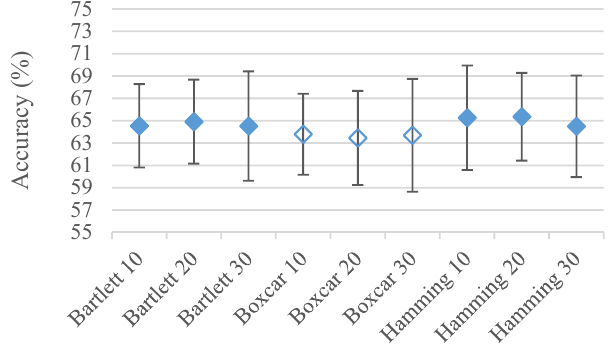
Figure 6. Averaged accuracies and standard deviations for Bartlett, Boxcar, and Hamming windows, in the case of 10, 20, and 30 ms frame lengths, and 8 kHz maximal frequency. Filled marks show equally performing settings.